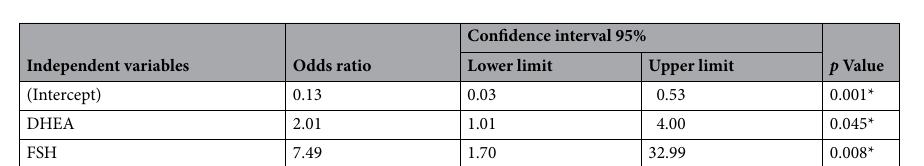
Table 4. The estimates of significant associations between autism and hormones concentration using logistic regression modeling. * p ≤ 0.05 is considered statistically significant.